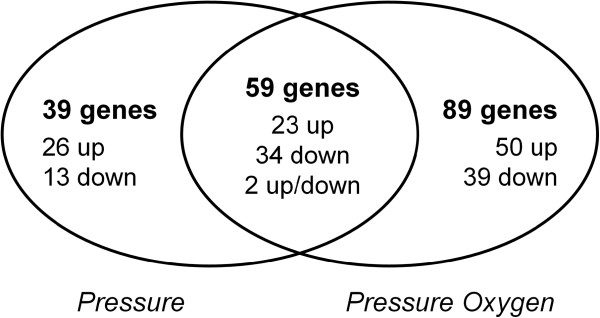
Number of significantly differentially expressed genes. “Pressure” and “Pressure Oxygen” refer to the genes differentially expressed at elevated pressure and at combined elevated pressure and elevated DOT, respectively. The number of genes overexpressed compared to the Control condition is described as “up”, the number of genes underexpressed as “down”, and the number of genes overexpressed in one condition but underexpressed in the other one as “up/down”.